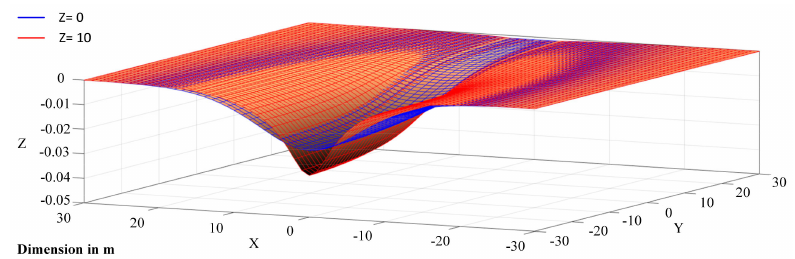
Figure 4. Settlement trough in di ff erent depth stratum (example).